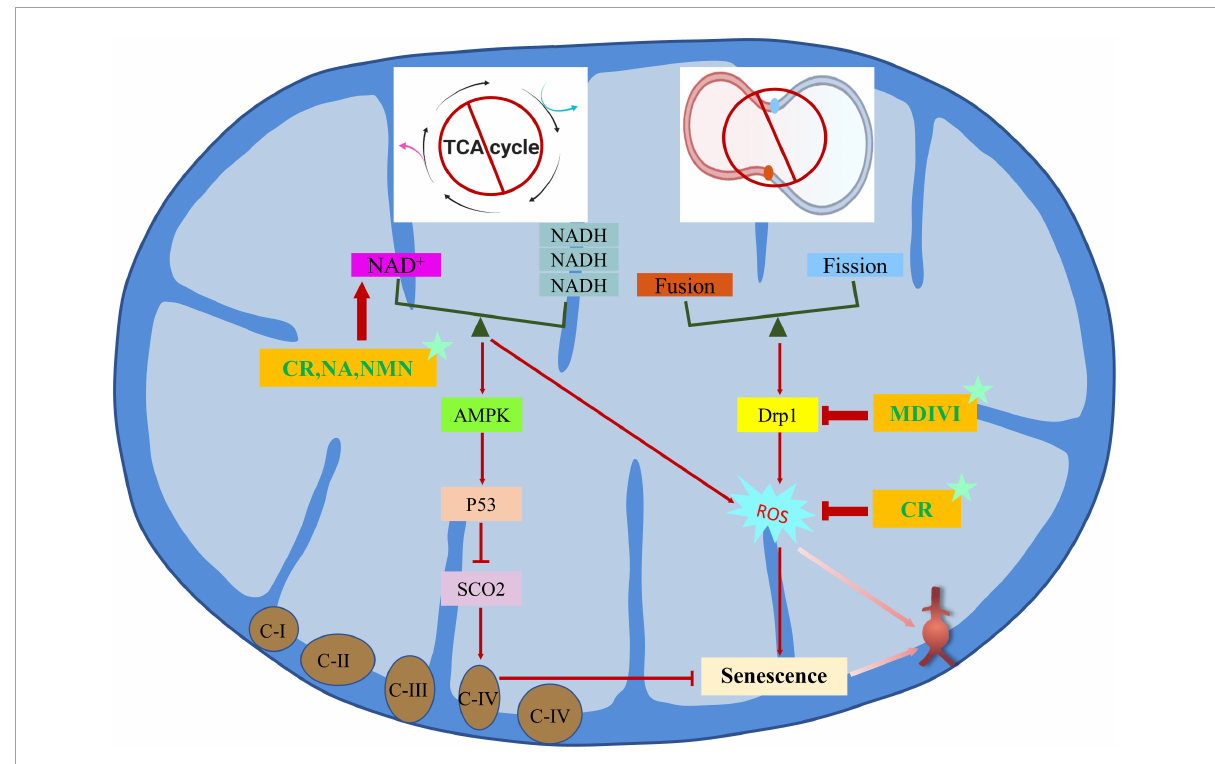
FIGURE4 Regulation mechanism and intervention between mitochondrial dysfunction-related senescence and